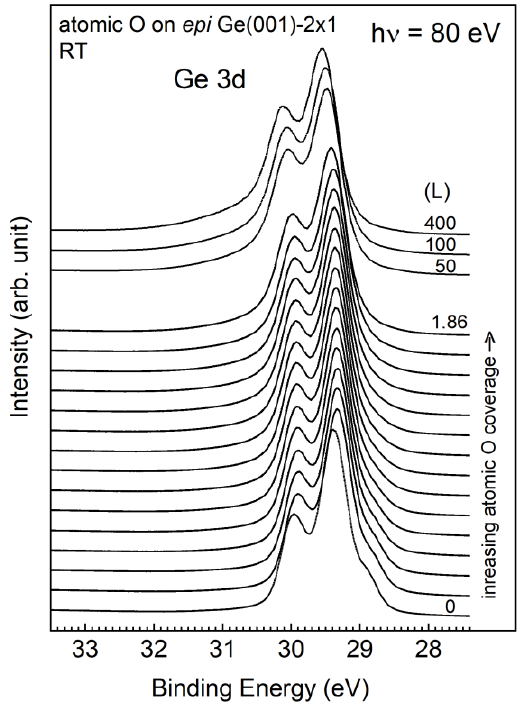
Figure 5. Development of the Ge 3d core-level spectra with various dosages of atomic O on an epi Ge(001)-2 × 1 surface at room temperature.